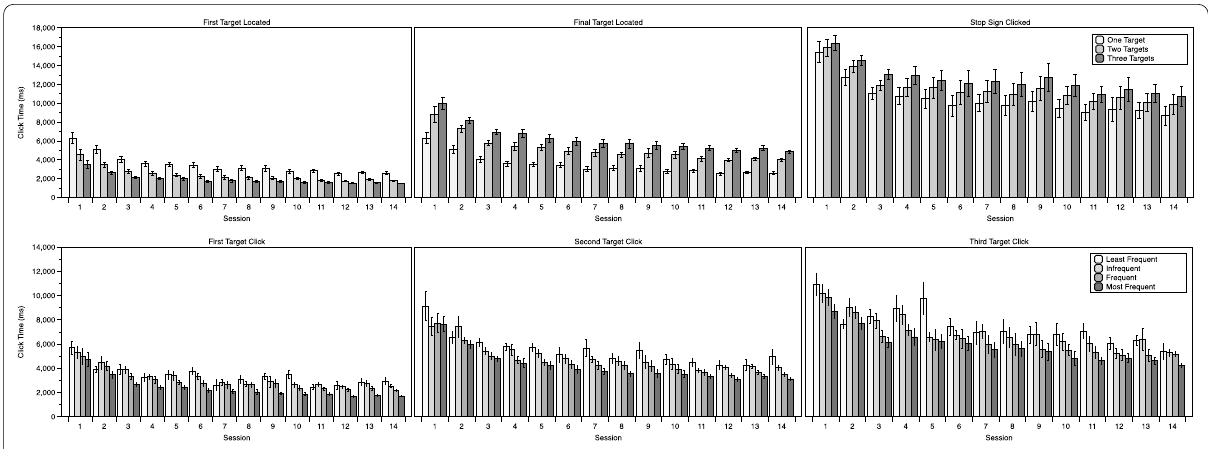
Fig. 16 Top: Average click times (ms) for locating the first target (left panel), final target (middle panel), and the stop sign to end the trial (right panel) as a function of the number of targets present in the display. Bottom: Average time (ms) to click on the first (left panel), second (middle panel), and third (right panel) targets in multiple-target trials as a function of target frequency. Error bars are standard